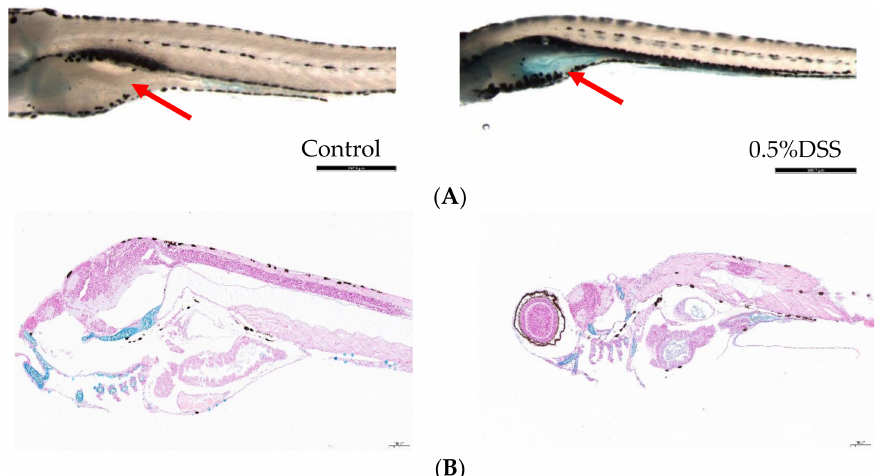
Figure 1. Alcian blue staining of zebrafish in blank group and 0.5% DSS model group. ( A ) Whole- mount control and DSS-exposed larvae stained with alcian blue. Red arrows indicate intestinal bulb staining, scale bar: 380 µ m. ( B ) Alcian blue staining of longitudinal sections of juvenile fish from the blank and DSS-induced groups, scale bar 100 µ m.